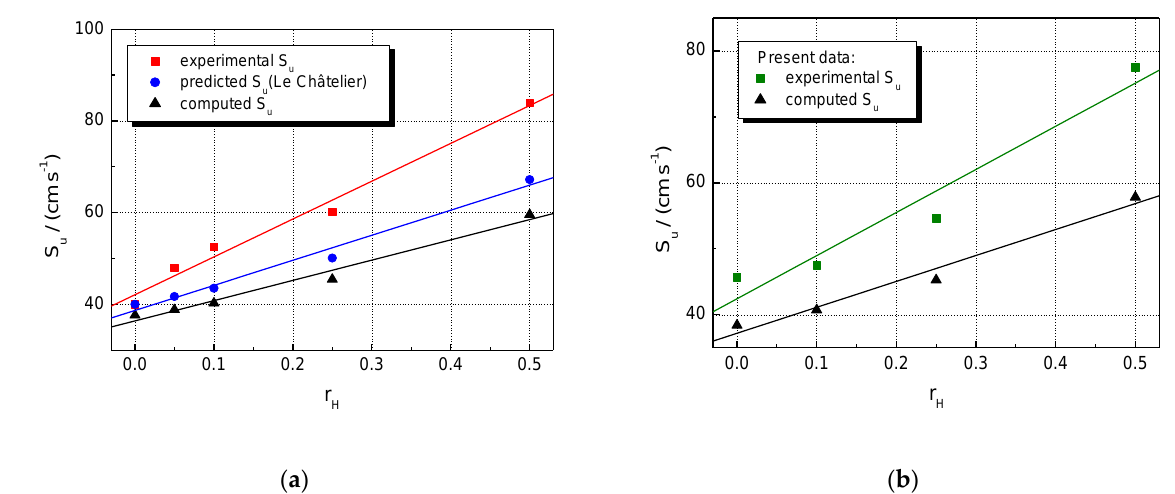
Figure 6. Laminar burning velocities of stoichiometric multifuel–air mixtures with various r H at ambient initial pressure and temperature: ( a ) CH 4 – H 2 – air; ( b ) NG – H 2 – air mixtures.